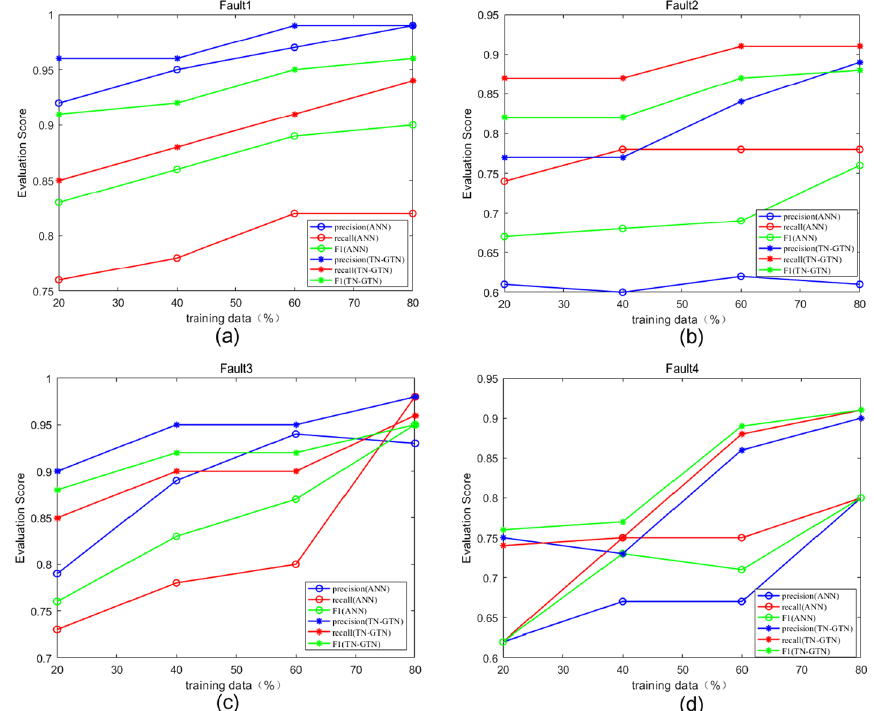
Fig. 12 Experimental results for different fault classification: a Fault1; b Fault2; c Fault3; and d